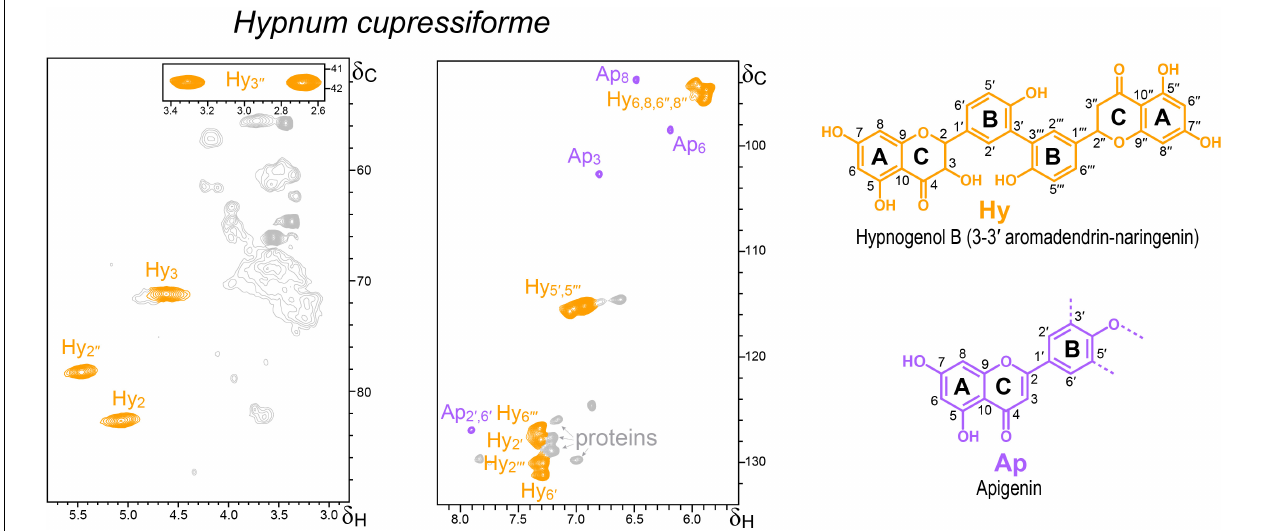
FIGURE 3 | Aliphatic-oxygenated ( δ C / δ H 50–90/2.8–5.8) and aromatic ( δ C / δ H 92–134/5.6–8.2) regions of the HSQC spectrum of the lignin-like preparation isolated from the moss H. cupressiforme . The main signals correspond to the flavonoids apigenin (Ap) and hypnogenol B (Hy), whose structures are shown on the right.